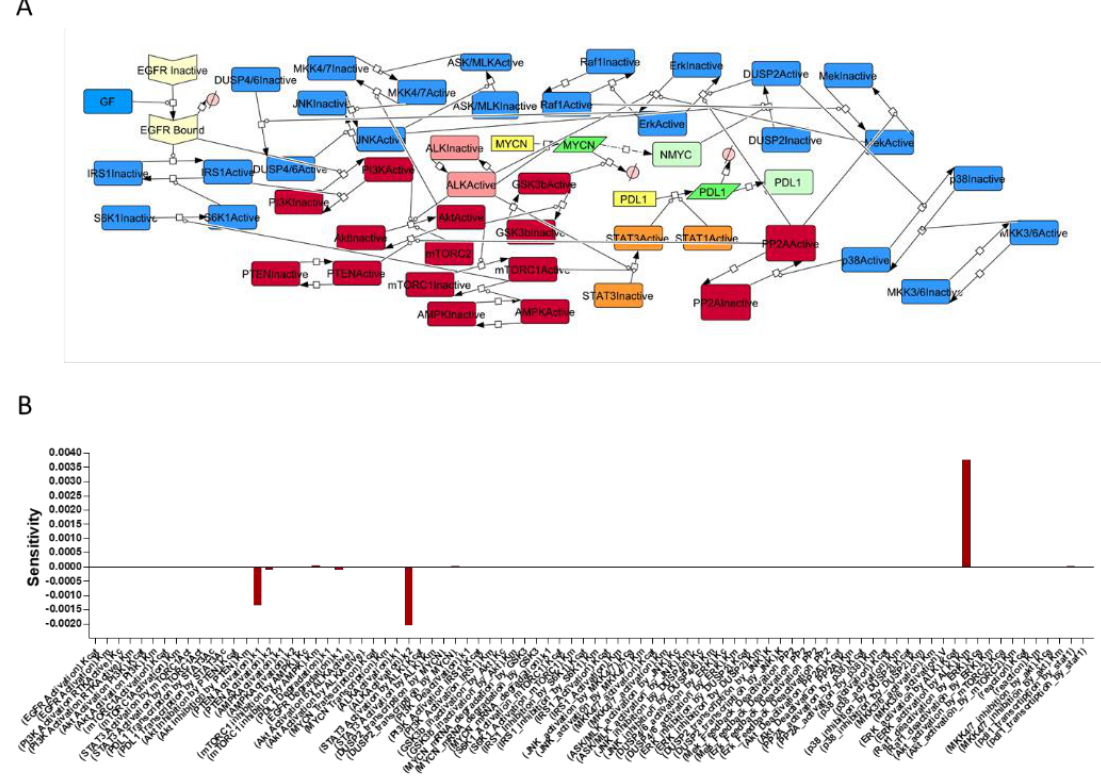
Figure 2. Simplified pathway used for the sensitivity analysis ( A ). The sensitivity analysis shows the influence of reaction parameters (Kcat, Km, k1 or k2) on PD-L1 transcription. Negative values indicate repression of transcription, while positive ones indicate an induction. The Km of ERK (Extracellular signal–Regulated kKinase) activation by ALK (Anaplastic Lymphoma Kinase) was the parameter most associated with PD-L1 expression. A strong negative value was elicited for k1 of PTEN (Phosphatase and Tensin homolog) activation and k2 of ALK activation, meaning that both the parameters were inversely proportional to PD-L1 expression ( B